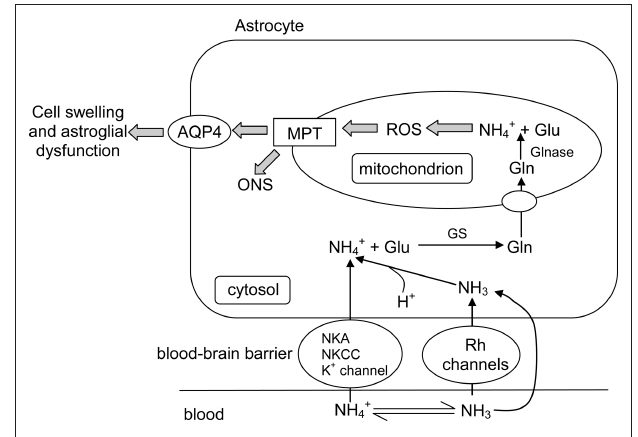
Figure 2 | A hypothetical scheme of ammonia-induced astrocyte swelling resulting from (a) the permeation of NH and NH 4+ through the 3 blood–brain barrier with or without the aid of transport proteins (NKA, Na + /K + -ATPase; NKCC, Na + :K + :2Cl − -cotransporter; rh channels, rhesus glycoprotein channels) from the blood to the brain, (b) an increase in glutamine (gln) synthesis from NH 4+ and glutamate (glu) catalyzed by glutamine synthetase (gS) in the cytosol, (c) the entry of gln into the mitochondria, (d) the breakdown of gln by mitochondrial glutaminase (glnase) and the release of NH 4+ in the mitochondrial matrix, (e) an increase in the production of reactive oxygen species (rOS), (f) the induction of mitochondrial permeability transition (MPT), (g) the occurrence of oxidative/nitrosative stress (ONS) in the cell, and (h) the activation of aquaporin channels (e.g., AQP4), leading to the influx of water and resulting in swelling and astroglial